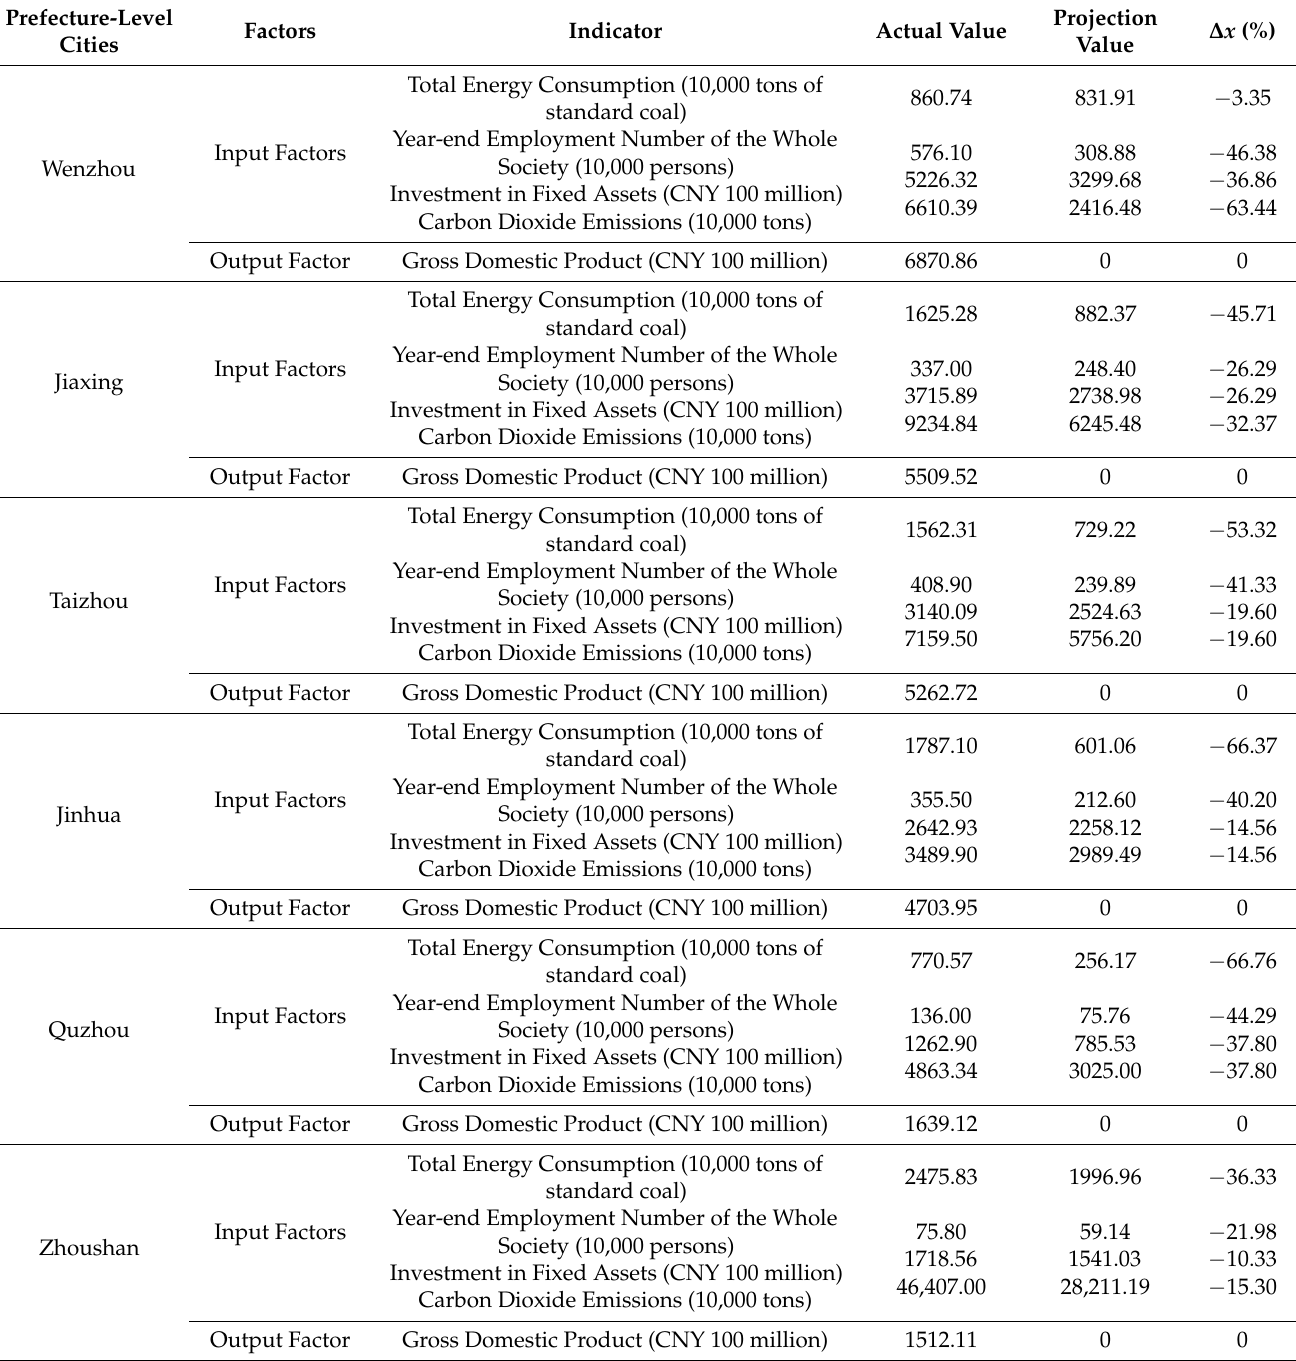
Table 3. Cause analysis of inefficient low-carbon economic efficiency in six prefecture-level cities.